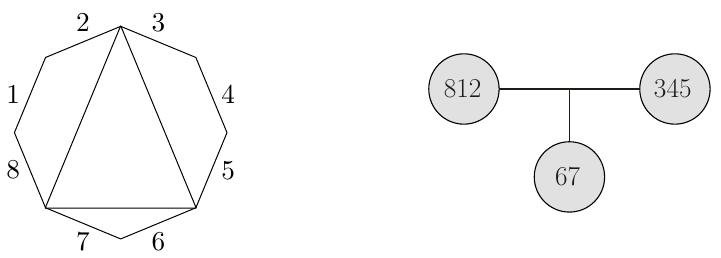
Figure 3. Mutual partial triangulation(left) for (1 , 2 , 3 , 4 , 5 , 6 , 7 , 8 | 8 , 1 , 2 , 6 , 7 , 3 , 4 , 5) and the cor- responding Feynman diagrams(right).